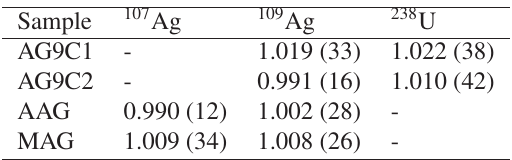
107 , 109 Ag and 238 U volume number Table 1. The ratios of densities derived from the NRTA to the volume number (cid:31) (cid:30) densities provided by the manufacturer.